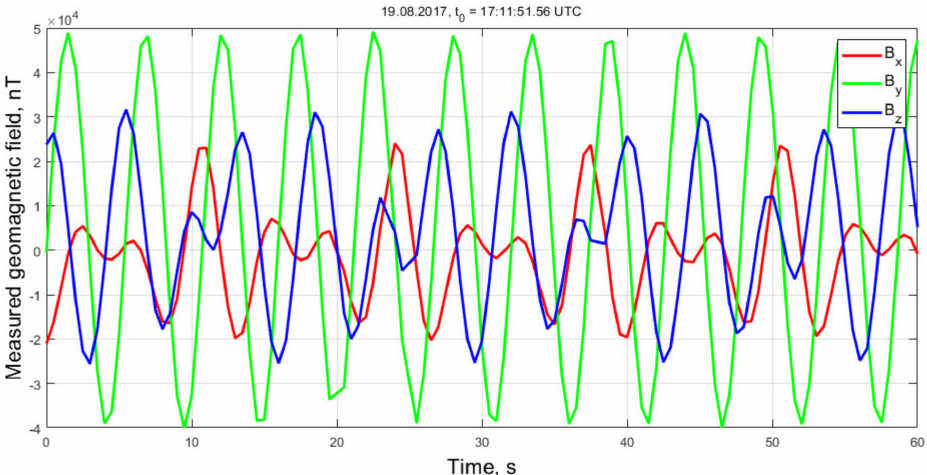
Figure 4. Measured geomagnetic field excluding bias.